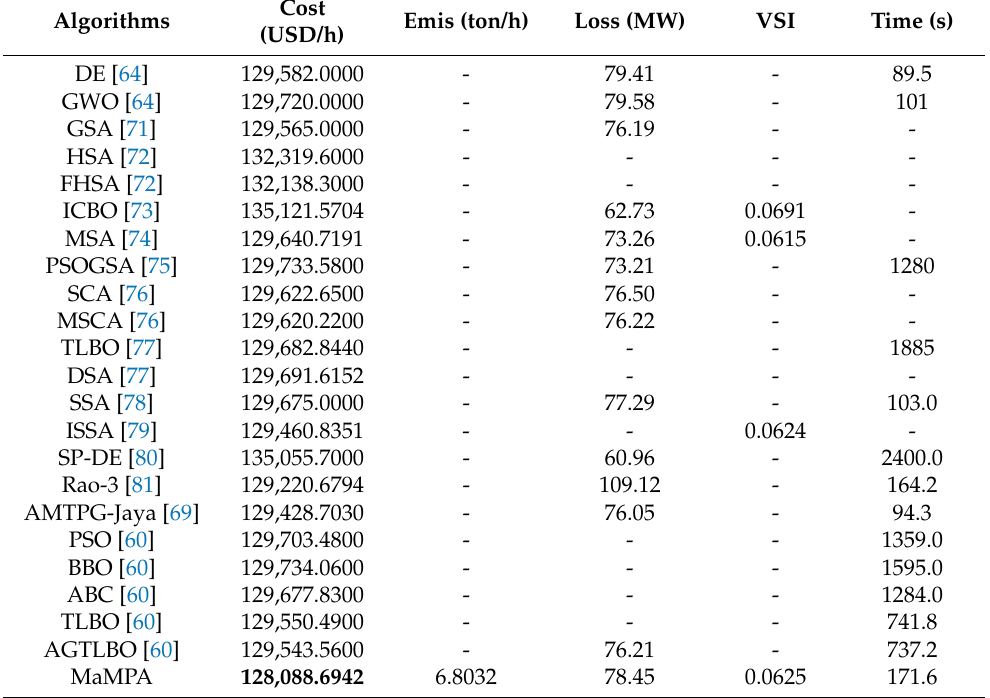
Table 6. Comparison results of case 5.